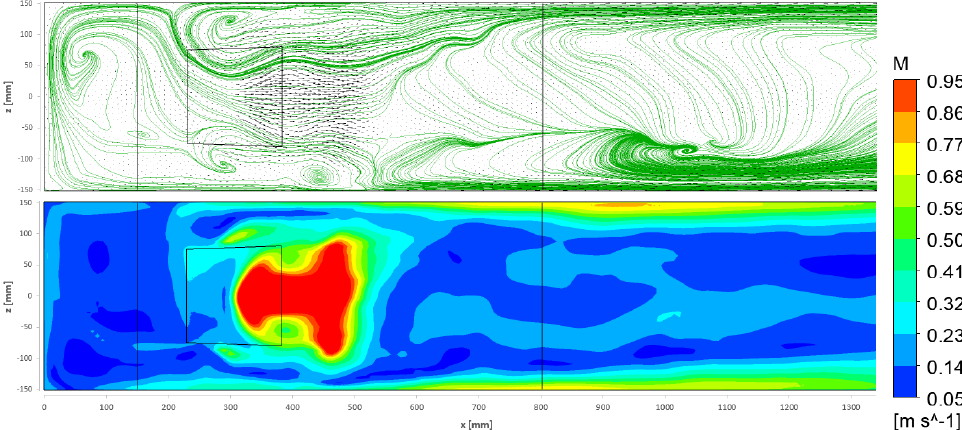
Figure 26. Finite volume method (SAS model), vector lines ( top ) and the magnitude of time-averaged 2D velocity ( bottom ) in horizontal plane ( y = 135mm ) .